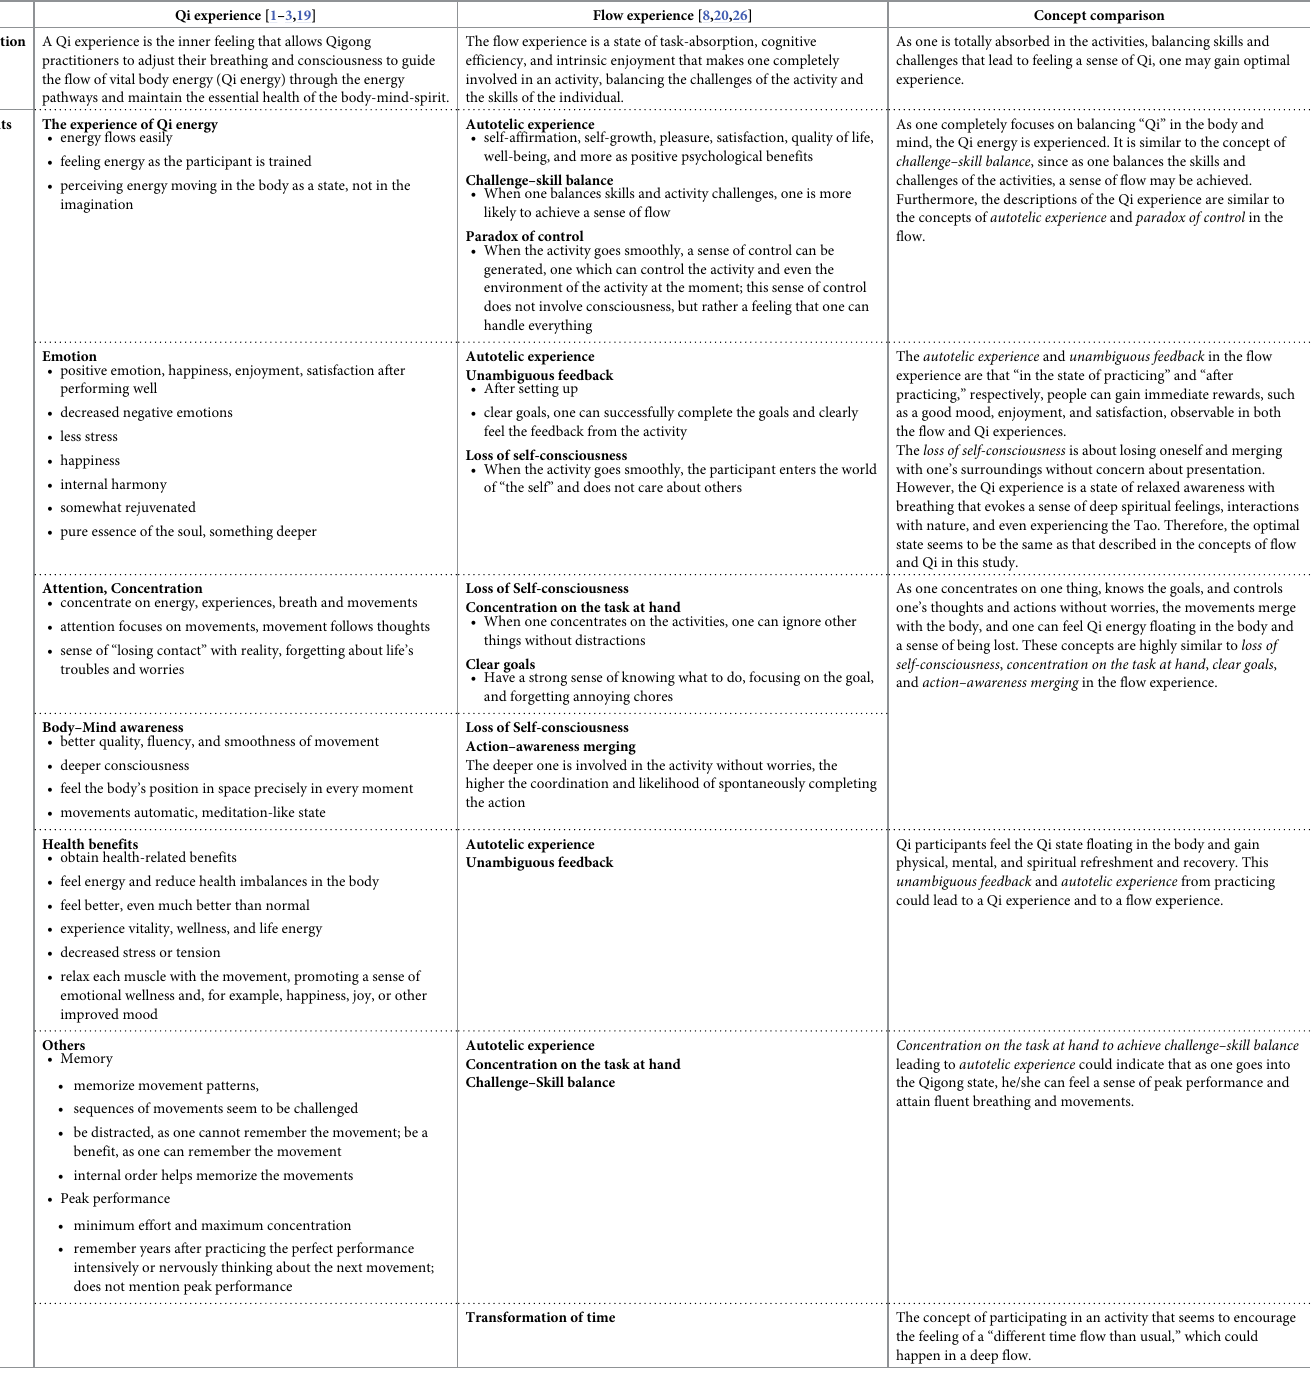
Table 1. A systematic evaluation of the construct validity of the Qi and flow